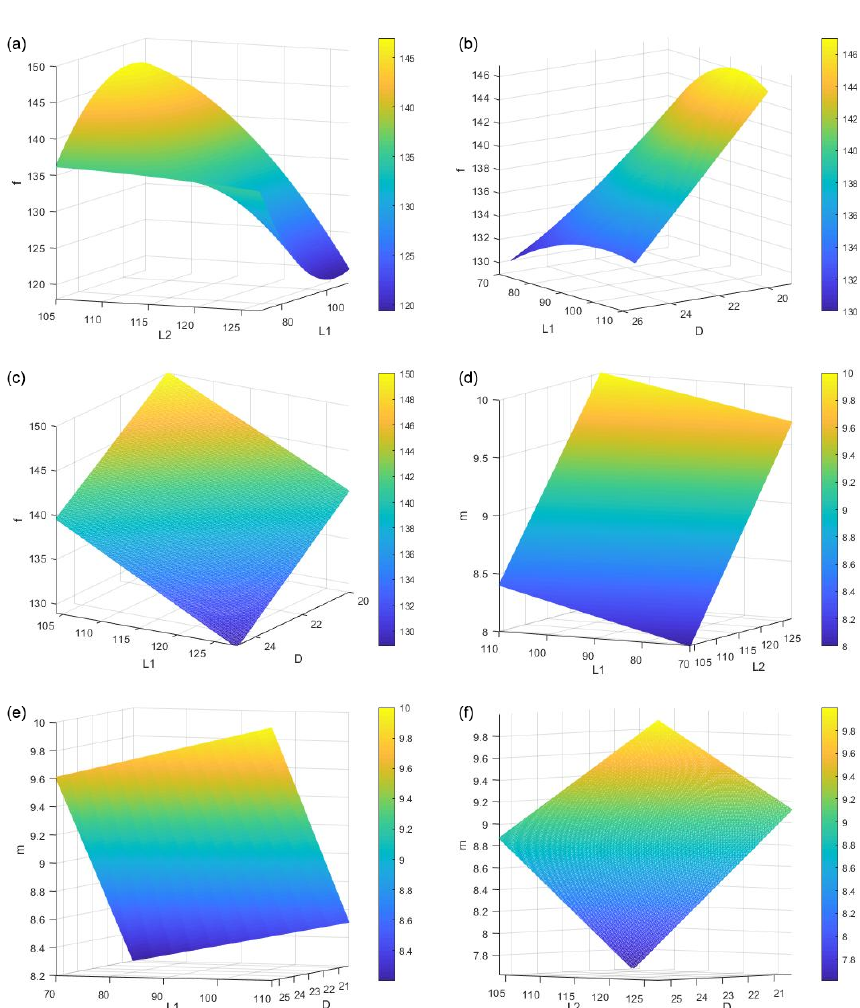
Figure 7. Relationship between objective function and design